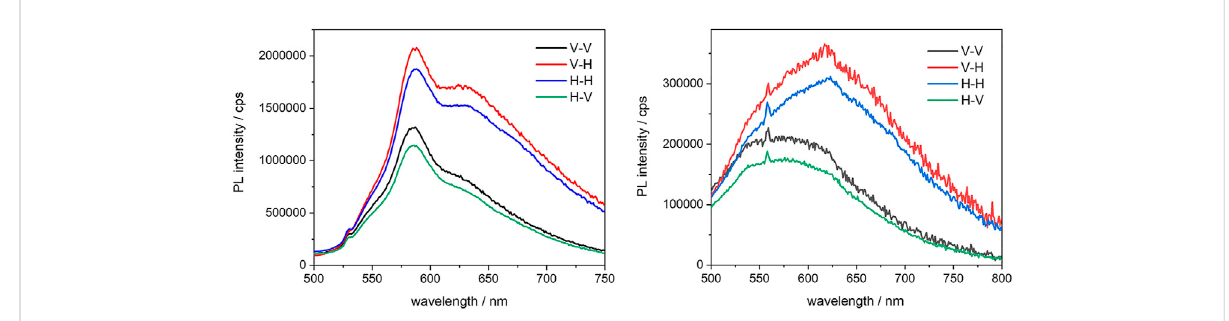
FIGURE 10 Emission anisotropy spectra of the1% (left) and the5% (right) BOPHY2-PMO, recordedat λ exc = 470 nm from powder thin fi lms; thenotationin the legend indicates the plane-polarisation of the excitation and the emission light beam,